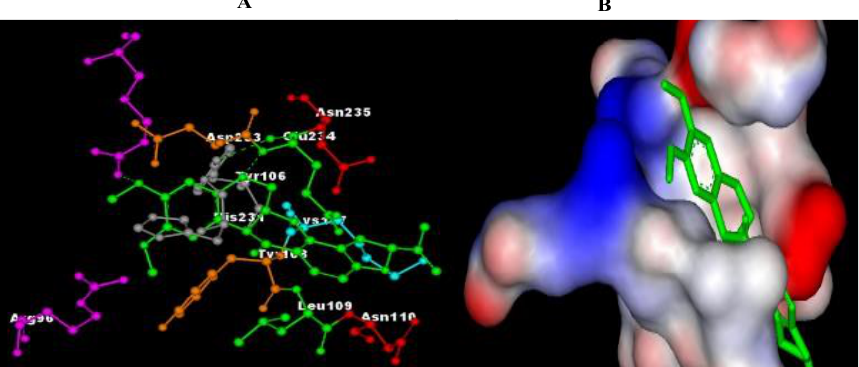
Figure 5. Pictorial representation of molecular docking analysis. ( A ) Binding orientation in the docked complex of CR with Punarnavine. ( B ) Surface representation of the CR binding pocket with the Punarnavine. The compound Punarnavine is represented in green. Images were generated using Discovery Studio visualizer.